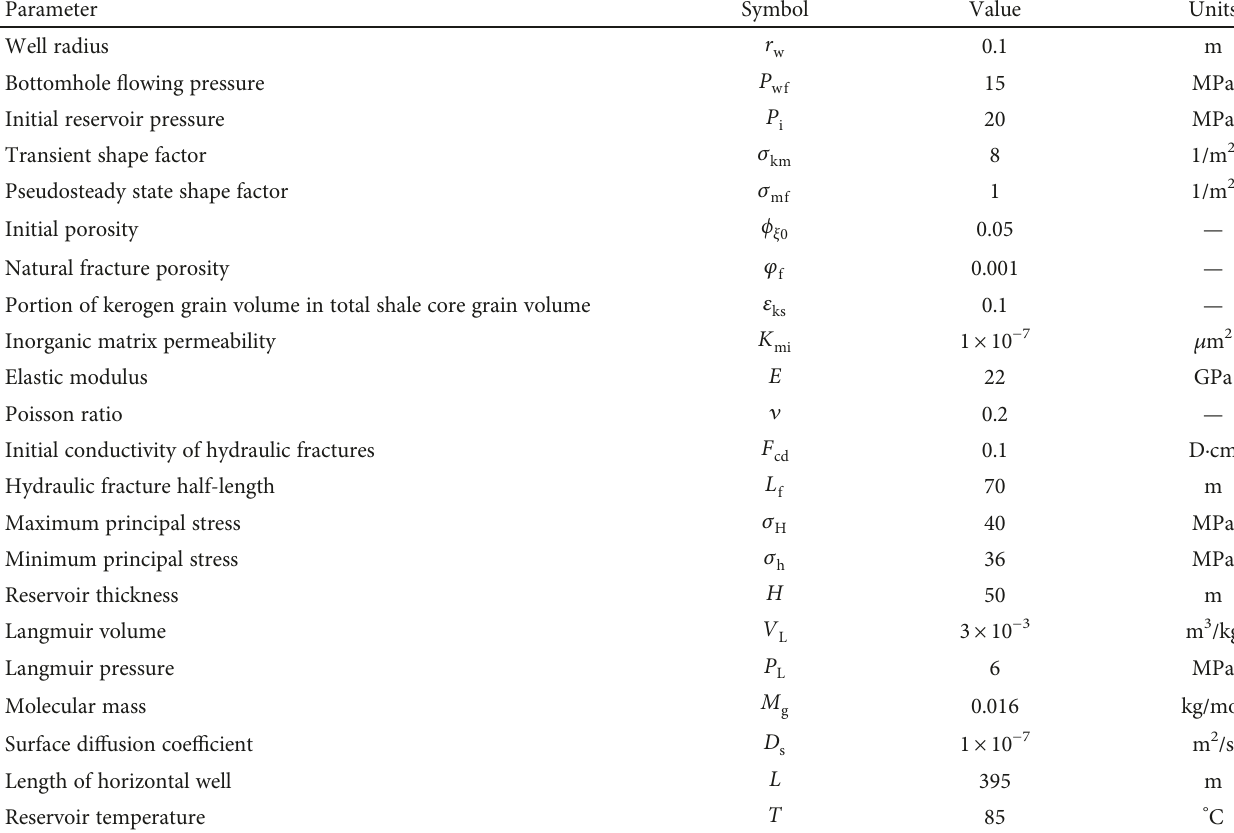
Table 1: Reservoir and wellbore geometry parameters for the simulation